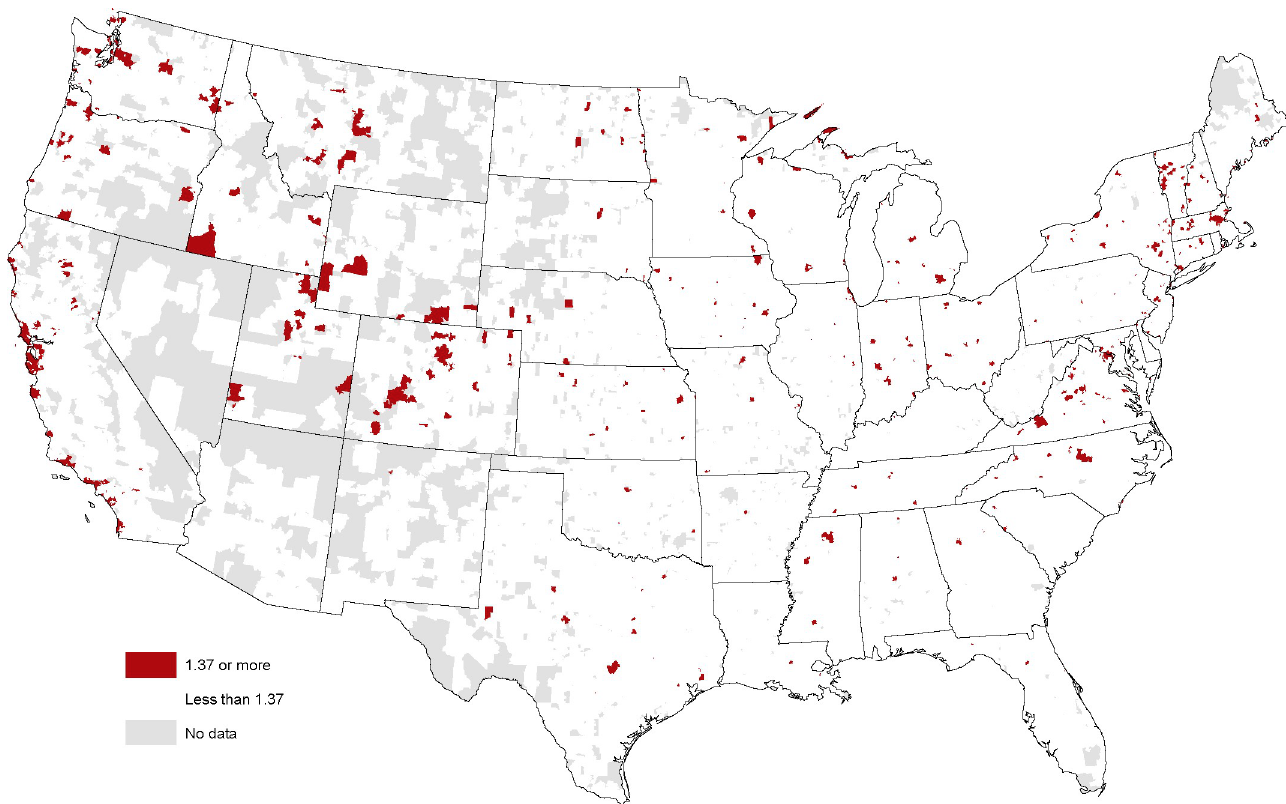
Fig 3. Design hotspots (index > 1.37) mapped at ZIP code level, January 2018. Sources: Esri, DStillery Custom Crafted Audience. Maps were created using ArcGIS 1 software by Esri. ArcGIS 1 and ArcMap ™ are the intellectual property of Esri and are used herein under license. Copyright Esri. All rights reserved. For more information about Esri 1 software, please visit www.esri.com.